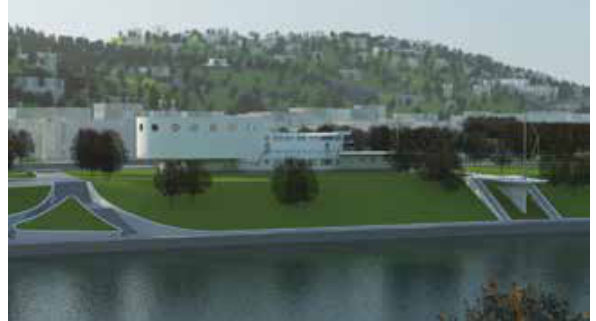
Figure 8. View from the opposite side of river of the 'Casa del Figure 6.Conceptual rendering of the 'Casa del Marinaretto' Marinaretto': human-eye view. Screen-shot by F. inserted in environmental context: bird-eye view. Screen-shot from video by F. Carota.